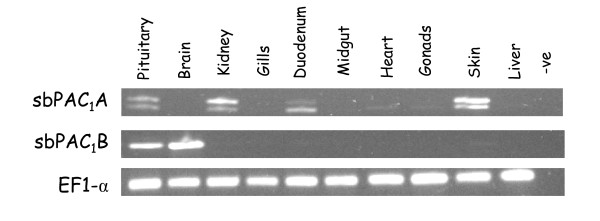
Tissue expression of the duplicate sbPAC1A and sbPAC1B receptors. Expression was carried out by RT-PCR using specific primers to amplify potential receptor transcripts. PCR products of approximately 1200 bp, 1000 bp and 1280 bp were obtained and corresponded to sbPAC1A, sbPAC1B and sbPAC1Ahop1 isoform, respectively.